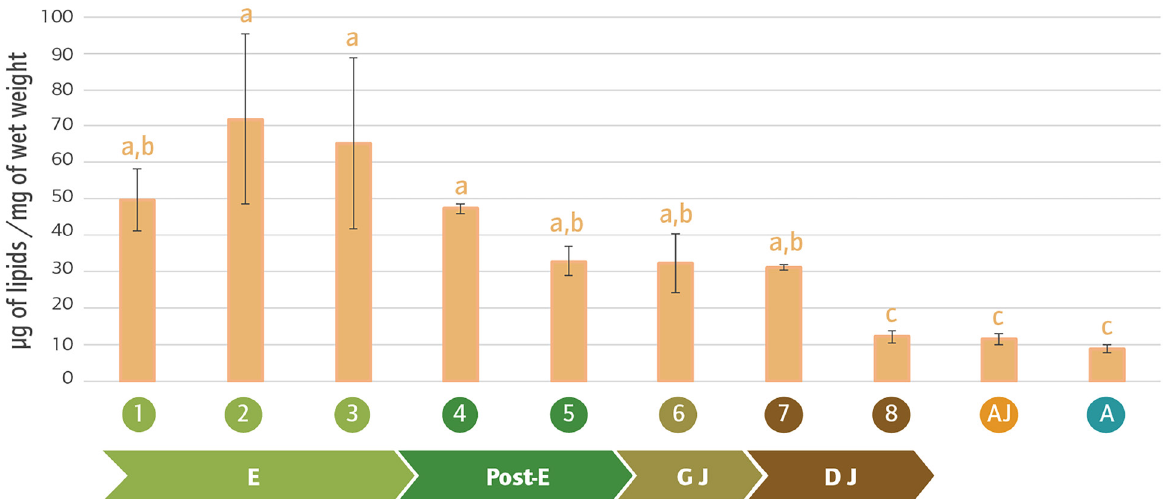
Figure 7. Analysis of total lipid concentration during P. pythagoricus development until adult’s stage. Values are the means ± SDs. Different letters above the bars indicate significant differences among the different stages at p < 0.05, as determined by Tukey’s post hoc test. 1 to 8: stages of P. pythagoricus development; AJ: advanced juvenile stage; A: adult stage; E: embryonic period; Post-E: post-embryonic period; GJ: juveniles in gregarious stage; DJ: juveniles in dispersal